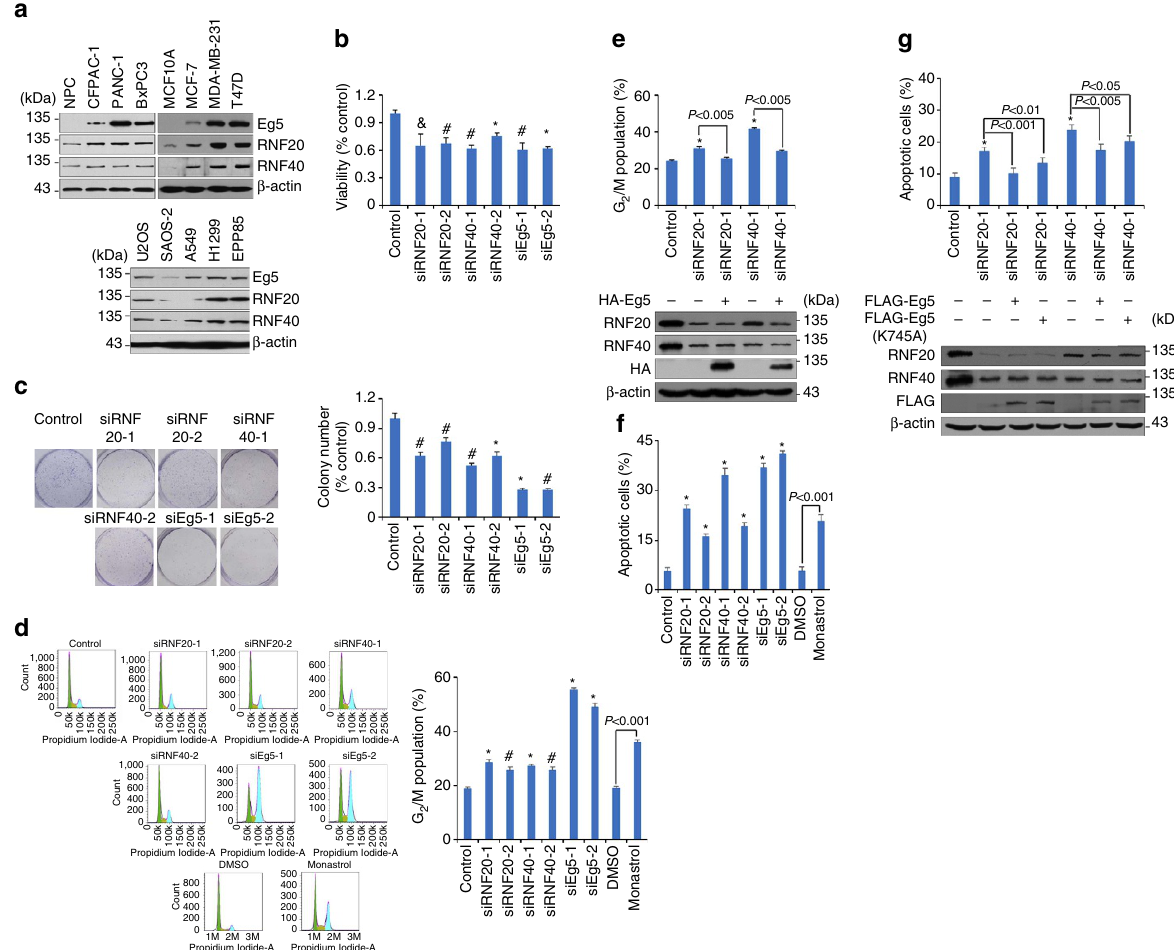
Figure 6 | Loss-of-function of RNF20/40 leads to cell G 2 /M arrest and apoptosis via downregulating Eg5. ( a ) The expression of Eg5 and RNF20/40 in different human cells lines. Total proteins from indicated cells were extracted, and western blotting was performed using indicated antibodies. ( b ) Depletion of Eg5 and RNF20/40 decreases the viability of MCF-7 cells. MCF-7 cells were treated with indicated siRNAs for MTTassays. ( c ) Colony formation assay. MCF-7 cells transfected with indicated siRNAs were maintained in culture media for 8 days and stained with crystal violet, and the number of colonies in each condition was counted. ( d ) Depletion of Eg5, RNF20/40 and inhibition of Eg5 activity induced G 2 /M arrest. MCF-7 cells treated with indicated siRNAs or 100 m M monastrol were stained with propidium iodide and subjected to flow cytometry. ( e ) Eg5 overexpression offset RNF20/40 depletion- induced G 2 /M arrest. MCF-7 cells with RNF20 or RNF40 depletion were transfected with the empty vector or HA-Eg5, and the cell cycle was analysed using flow cytometry. The P value between the indicated treatments is determined by Student’s t -test. Western blotting was performed using antibodies against the indicated proteins. ( f ) Depletion of Eg5, RNF20/40 and inhibition of Eg5 led to cell apoptosis. Eg5, RNF20/40-depleted or monastrol-treated MCF-7 cells were stained with FITC-labelled annexin V and propidium iodide, followed by apoptotic analysis using flow cytometry. ( g ) Eg5 overexpression offset RNF20/40 depletion-induced apoptosis. The P value between the indicated treatments is determined by Student’s t -test. Western blotting was performed using antibodies against the indicated proteins. For all the bar charts in Fig. 6, each bar represents the mean ± s.d. for triplicate experiments and the P value were determined by Student’s t -test. & P o 0.01, # P o 0.005, * P o 0.001 versus